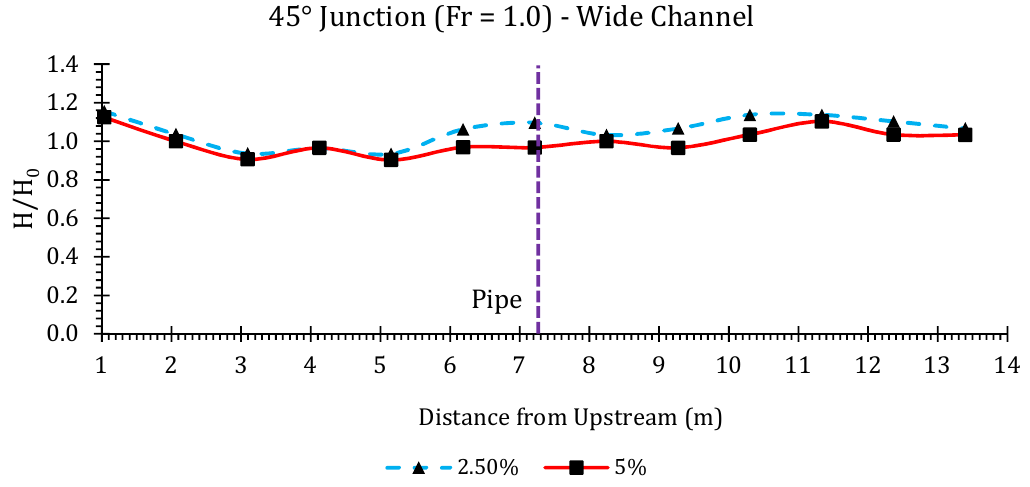
Figure A5. Water height ratios in a 45 ◦ junction for Fr = 1.0 in the wide Figure A5. Water height ratios in a 45° junction for Fr = 1.0 in the wide channel. Figure A5. Water height ratios in a 45° junction for Fr = 1.0 in the wide channel. Figure A5. Water height ratios in a 45° junction for Fr = 1.0 in the wide channel.